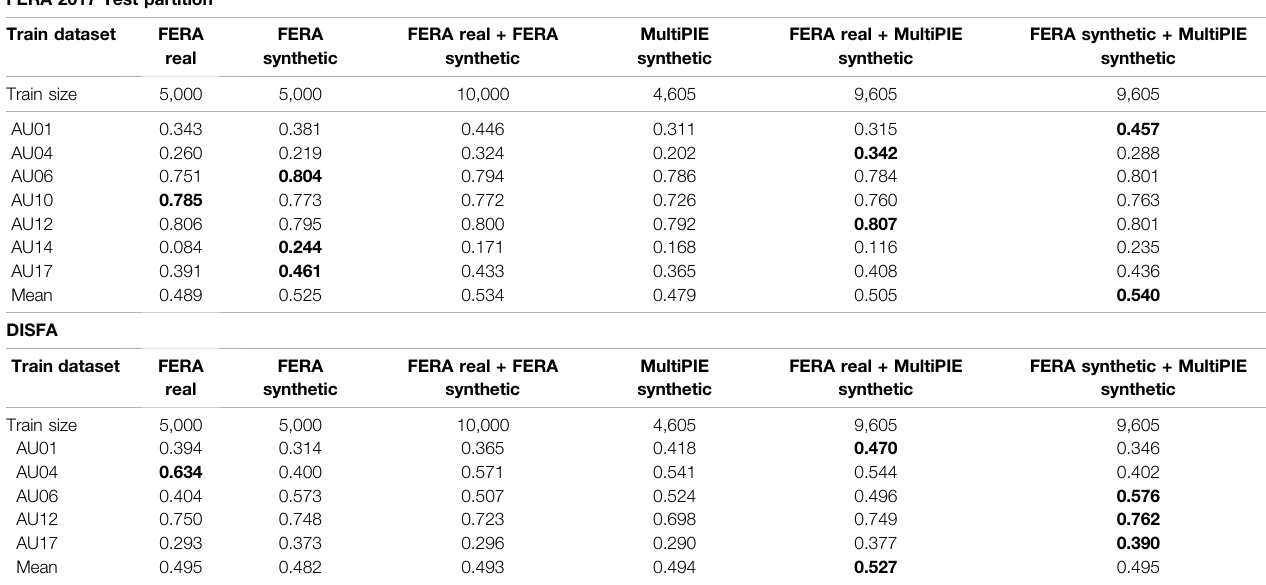
TABLE6| ICCcomparisonofmodelstrainedonsinglevs.combineddatasetsforFERA2017TestpartitionandDISFA.Trainingsizeisthenumberofimagesperintensityper AU used to train models. FERA 2017 Test partition